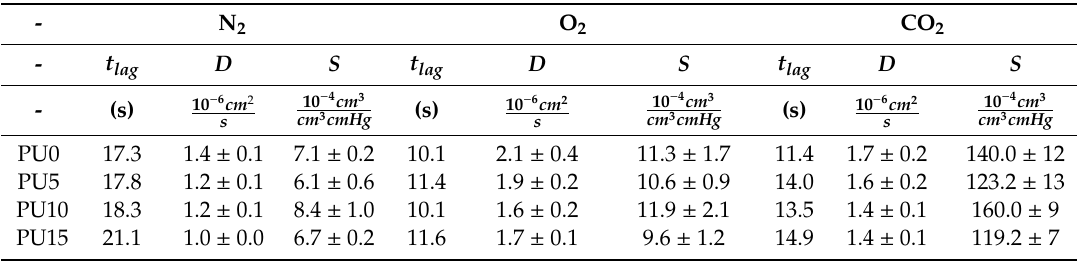
Table 3. Time lag ( tlag ) values, di ff usion coe ffi cients ( D ), and solubility coe ffi cients ( S ) obtained from Table 2. O 2 and CO 2 permeation curves for the PU0, PU5, PU10, and PU15 nonporous symmetric membranes.